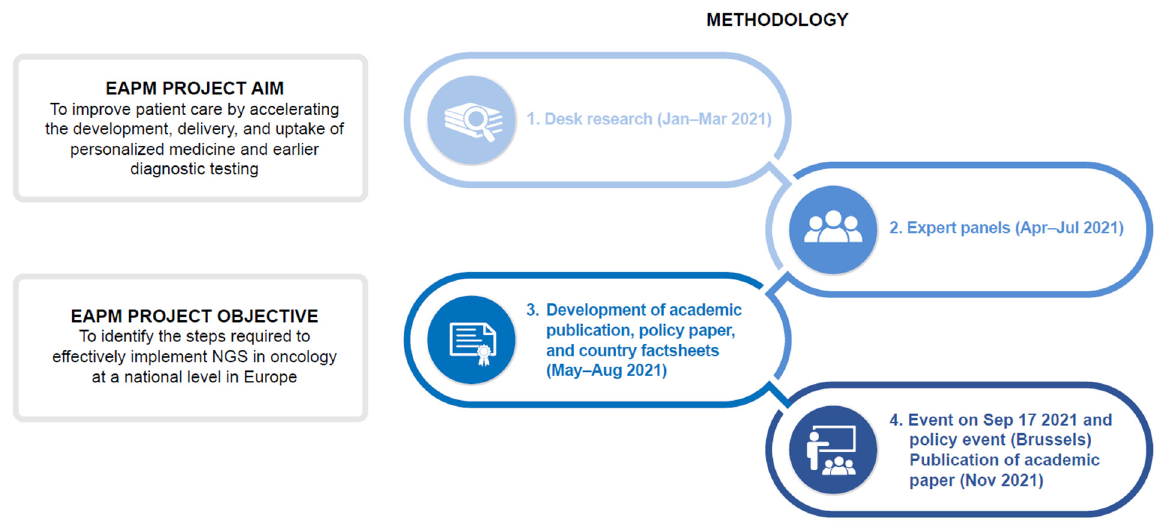
Figure 2. EAPM project overview. EAPM, European Alliance for Personalised Medicine; NGS, next-generation sequencing.